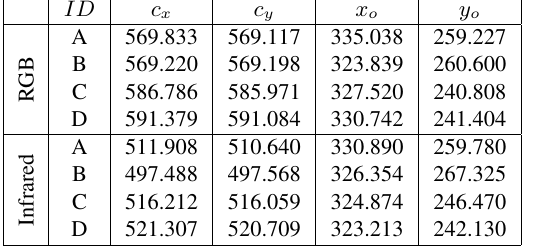
Table 3: Infrared and RGB camera internal parameters (in pixels)